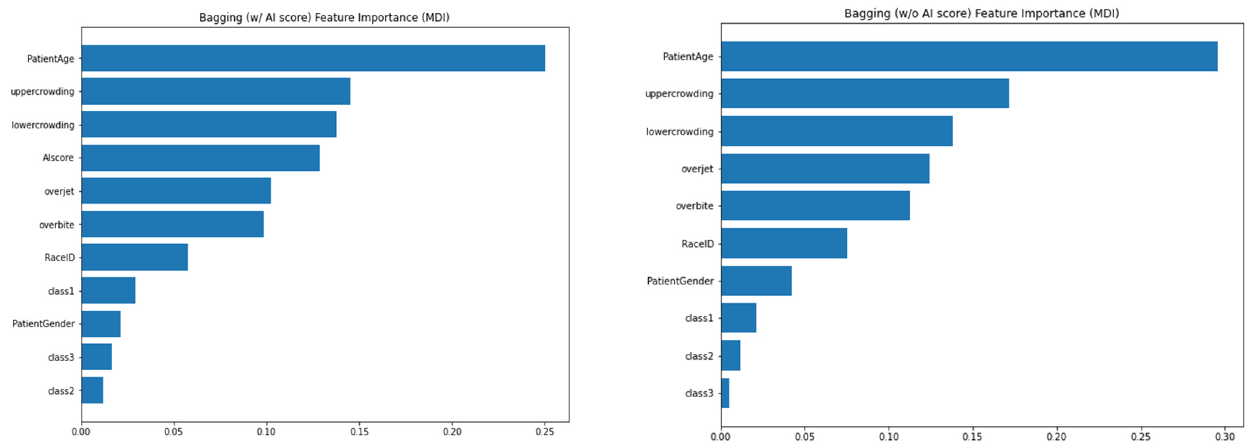
Figure 6. Feature importance for the Bagging model.